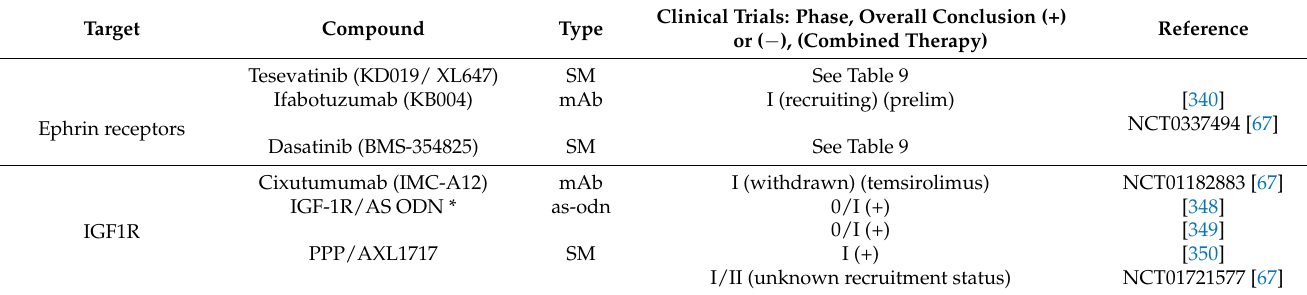
Table 8. Clinical trials in GB targeting the Ephrin receptors and the insulin-like growth factor 1 receptor.